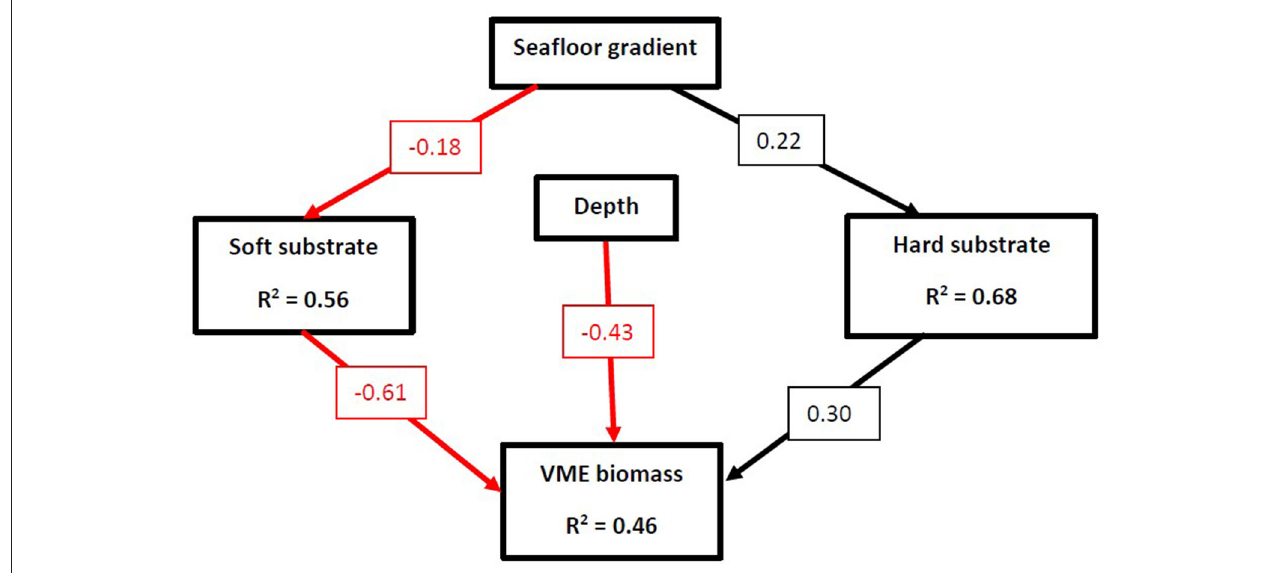
FIGURE 8 | Structural equational model (SEM) exploring the relationships between slope angle, depth, substrate cover, and estimated VME biomass. Arrows represent unidirectional relationships among variables, with black arrows denoting positive relationships and red arrows depicting negative ones. Only significant pathways ( P ≤ 0.05) are displayed. The standardized regression coefficient is given in the associated box. R 2 s for component models are given in the boxes of the response variable. Model incorporates random effect of Region. Hard substrate represents the combined cover of gravel, cobbles, pebbles, boulders, and bedrock. Soft substrate represents the combined cover of sand and